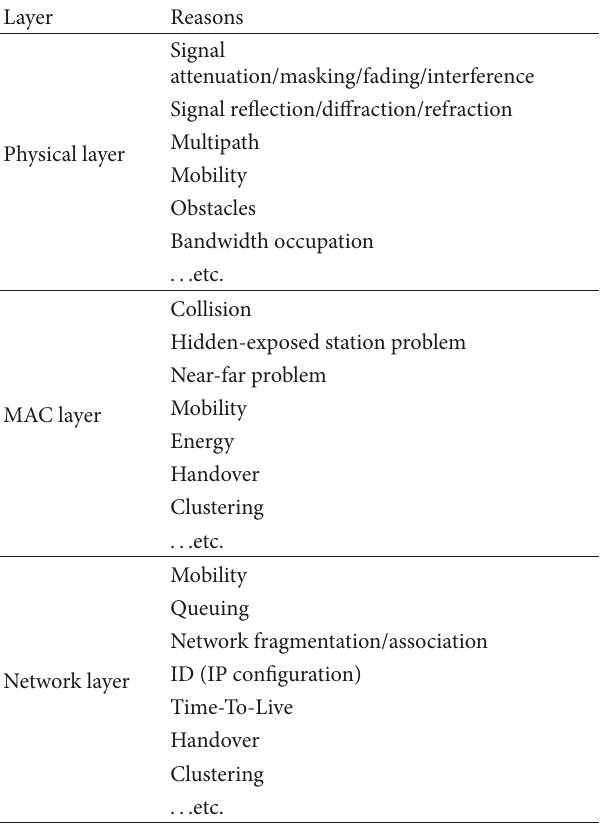
Table 1: Unintentional packet drop